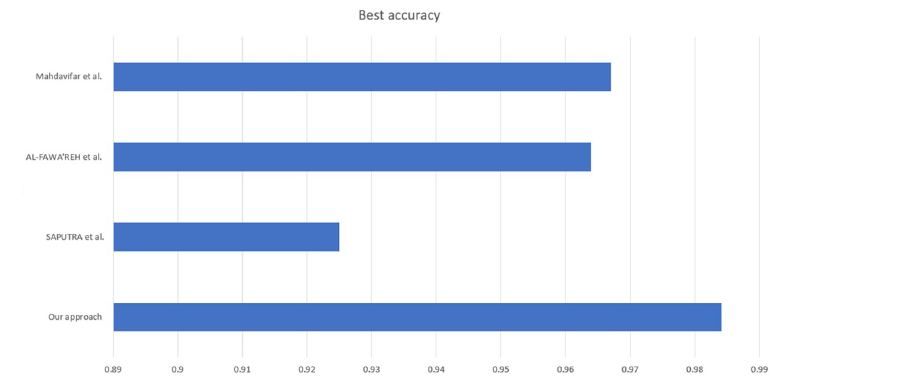
Fig 9. Accuracy comparison of other works to the proposed